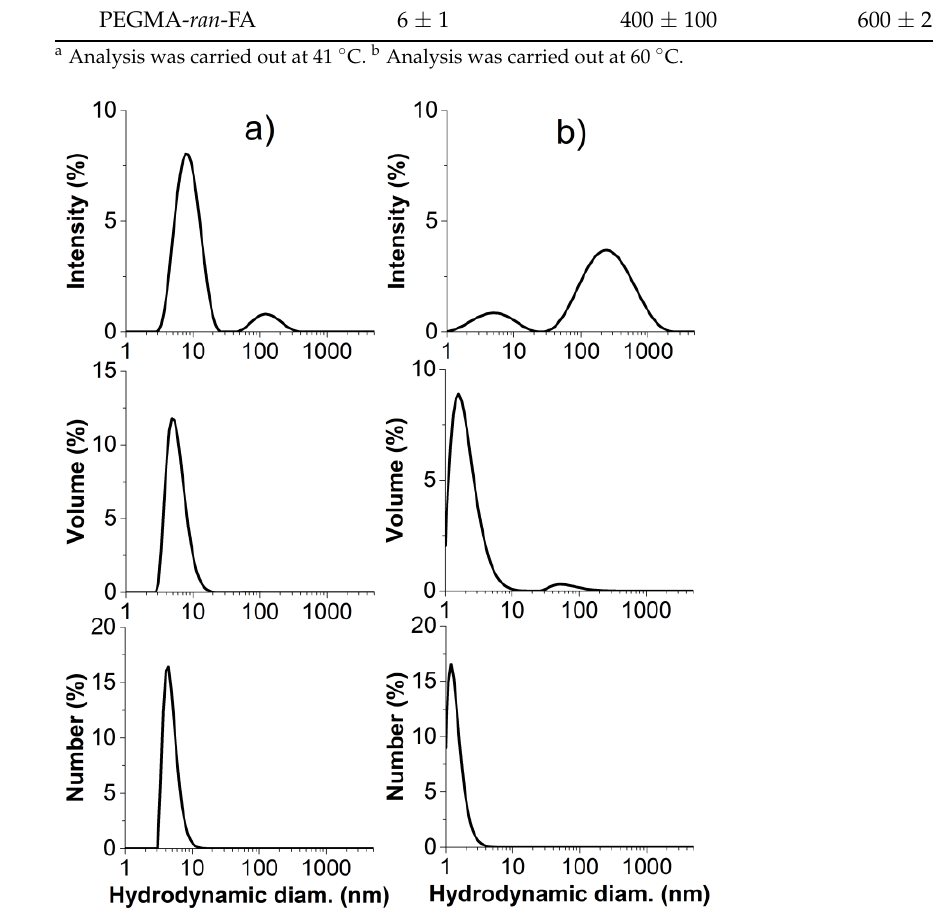
Figure 3. Intensity ( top ), volume ( middle ) and number ( bottom ) size distributions of ( a ) TEGMA- ran -FA and ( b ) PEGMA- ran -FA (25 °C, concentration of 30 g/L).